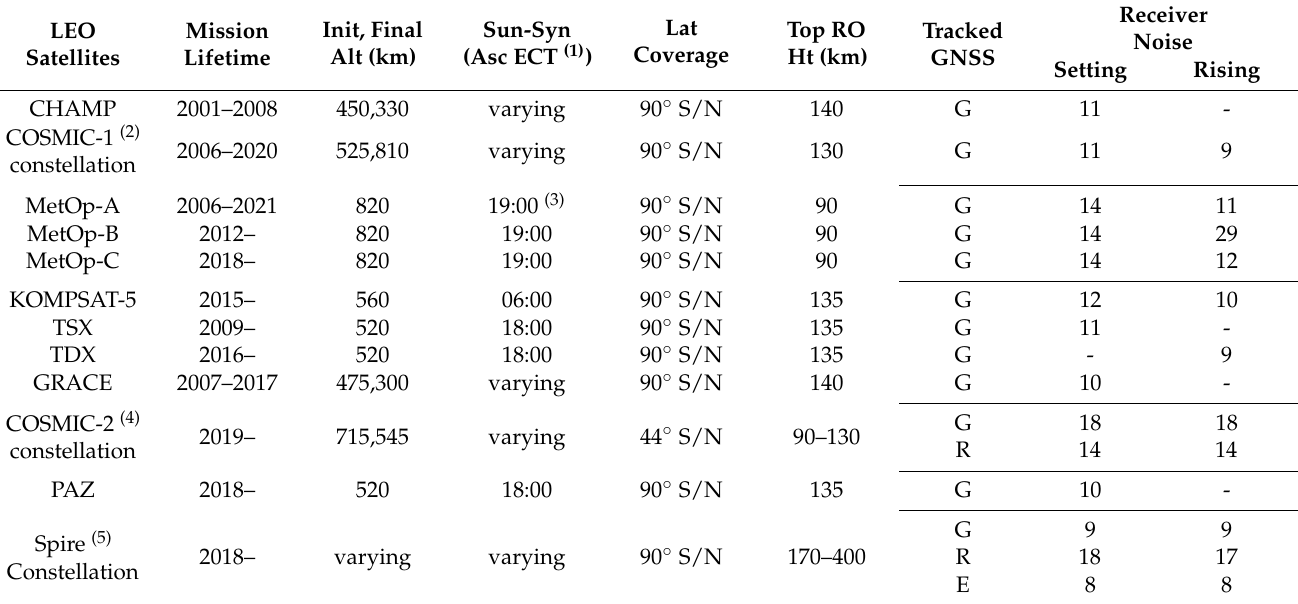
Table A1. Summary of GNSS-RO data in this